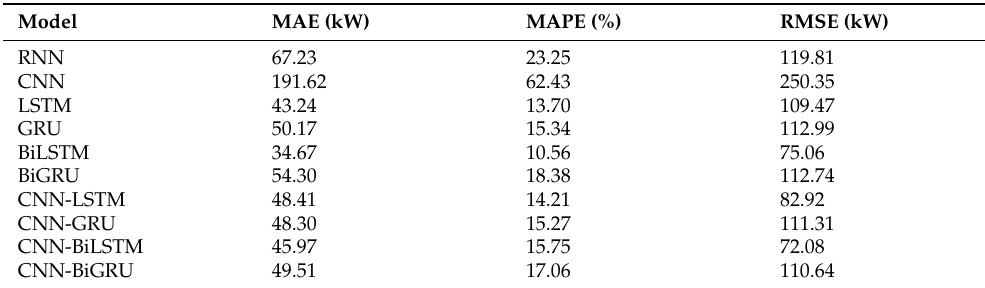
Figure 14. Performance comparison of the single model with one-week PV generation data. Table 6. MAE, MAPE, and RMSE values of one-week PV generation